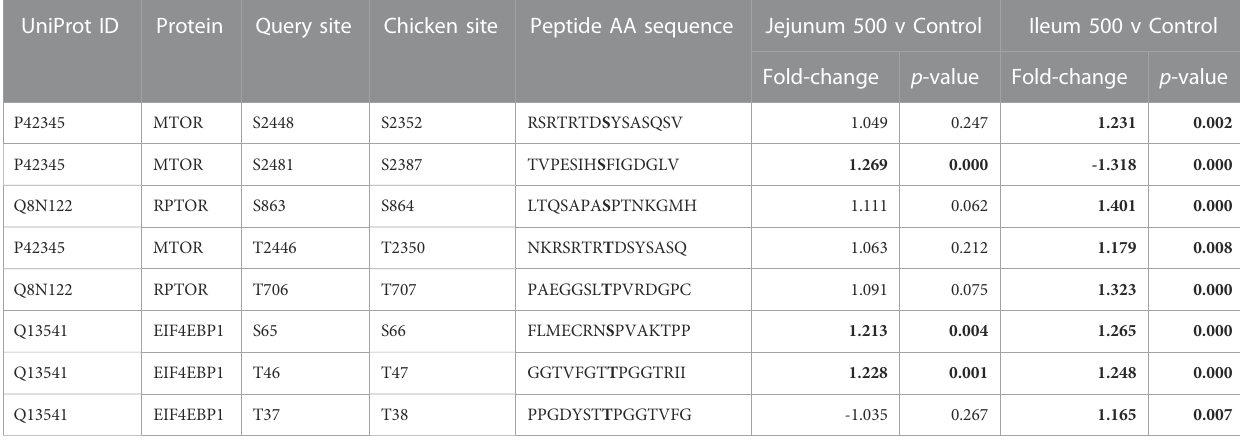
TABLE 6 mTOR and related proteins ’ phosphorylation events. Here, the kinome peptide array results are shown. Jejunum 500 and ileum 500 were compared to their respective control tissues. Phosphorylation events represented in this table show signi fi cant ( p -value < 0.05) for sites as described above. Signi fi cant values are highlighted in bold.